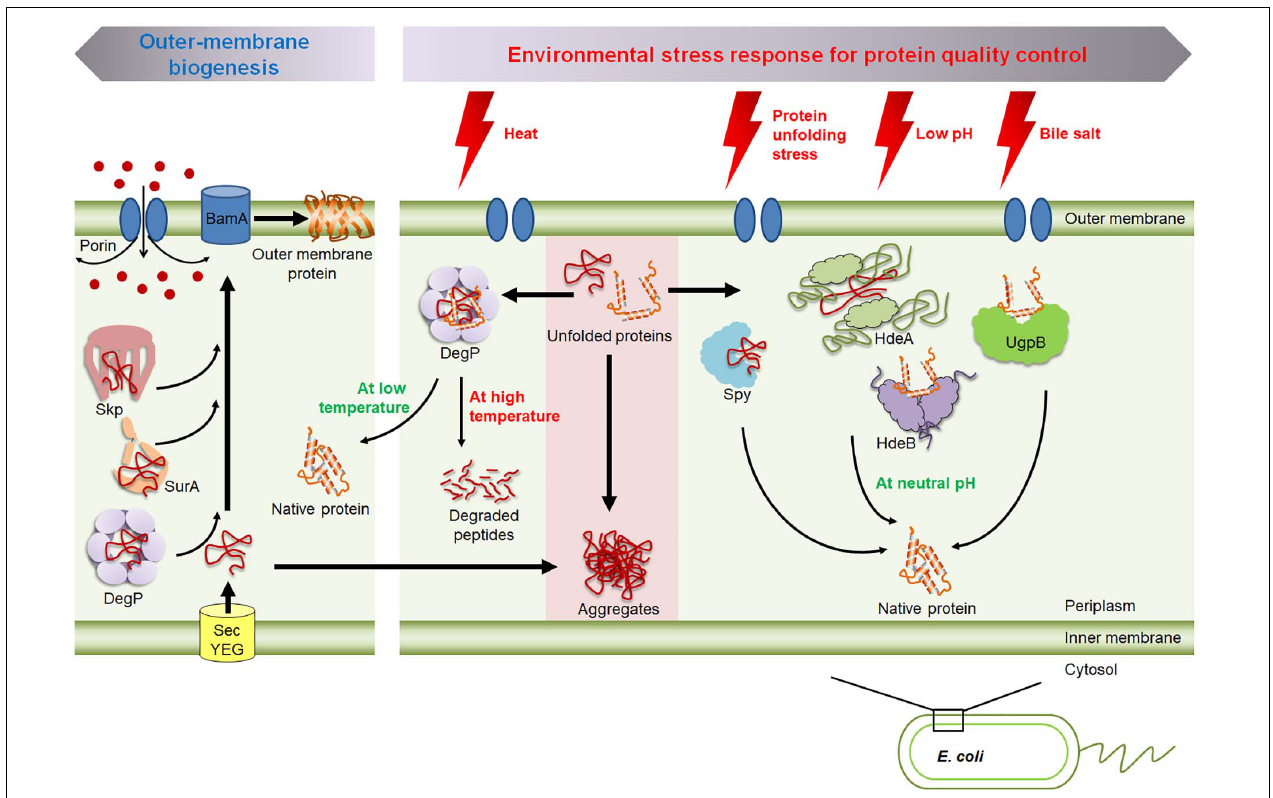
FIGURE 1 | An overview of the molecular chaperones in the periplasm of E. coli. Skp, SurA, and DegP are involved in the biogenesis of outer membrane proteins; i.e., preventing their aggregation and facilitating their insertion into the membrane. The shift of temperature modulates DegP’s chaperone and protease activity. HdeA and HdeB prevent acid-induced protein aggregation. Spy and UgpB respond to envelope stress and bile stress,